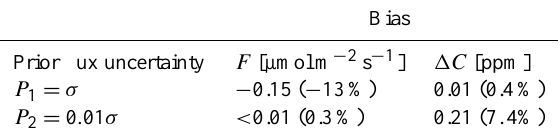
Table 1. Spring (MAM) biases in inverse surface CO 2 flux esti- mates for two prior flux uncertainties ( P 1 and P 2 ) with imposed 0.2ppm bias in simulated vertical gradients. The P 1 case is tightly constrained to the concentration measurements, whereas the P 2 case is tightly constrained to the perfectly specified prior flux. Prior flux uncertainties are scaled according to σ , the standard deviation of F